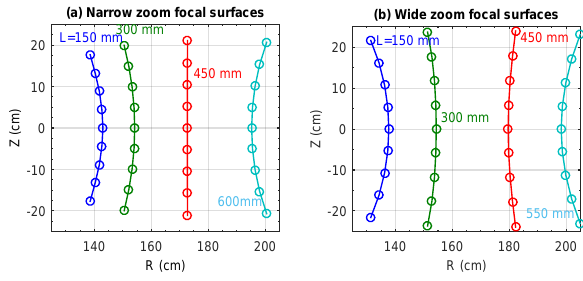
Figure 4. Focal plane with di ff erent positions of focal lens under narrow zoom and wide zoom